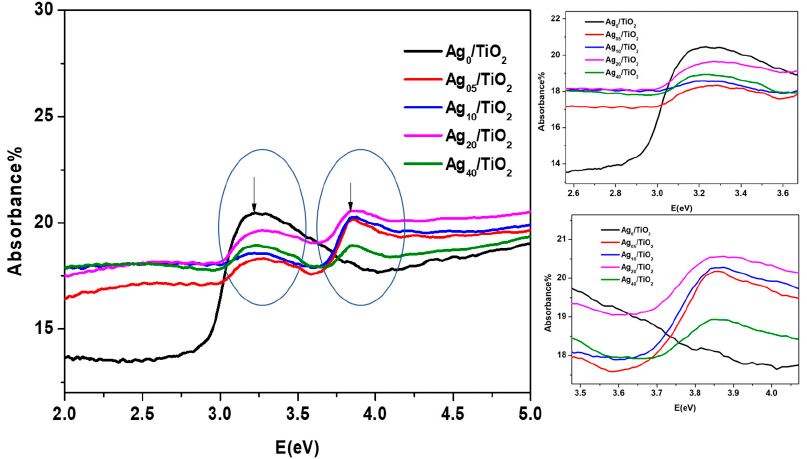
Figure 6. The absorbance spectra versus incident photon energy for Ag x /TiO 2 nanostructures.